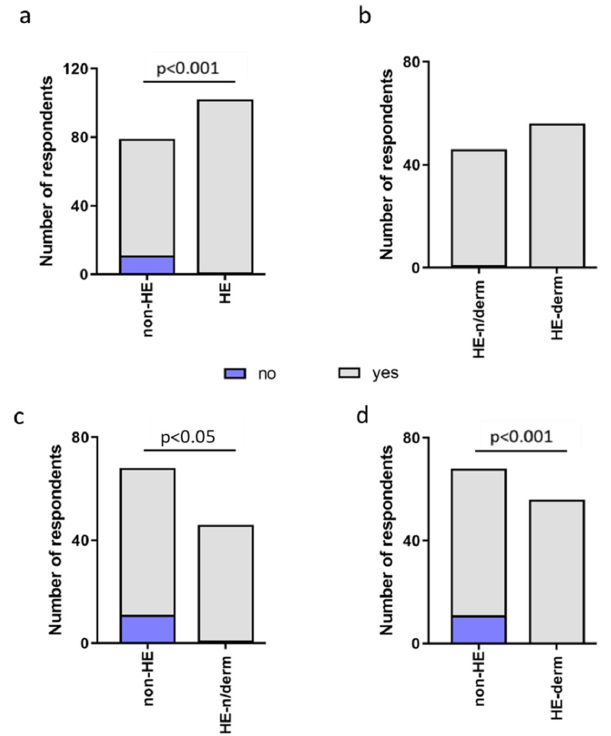
Figure 21. Comparison of moisturizing of the skin of the hands in study groups during pandemic: ( a ) non-HE vs. HE; ( b ) HE n/derm vs. HE-derm; ( c ) non-HE vs. HE n/derm; ( d ) non-HE vs. HE-derm.